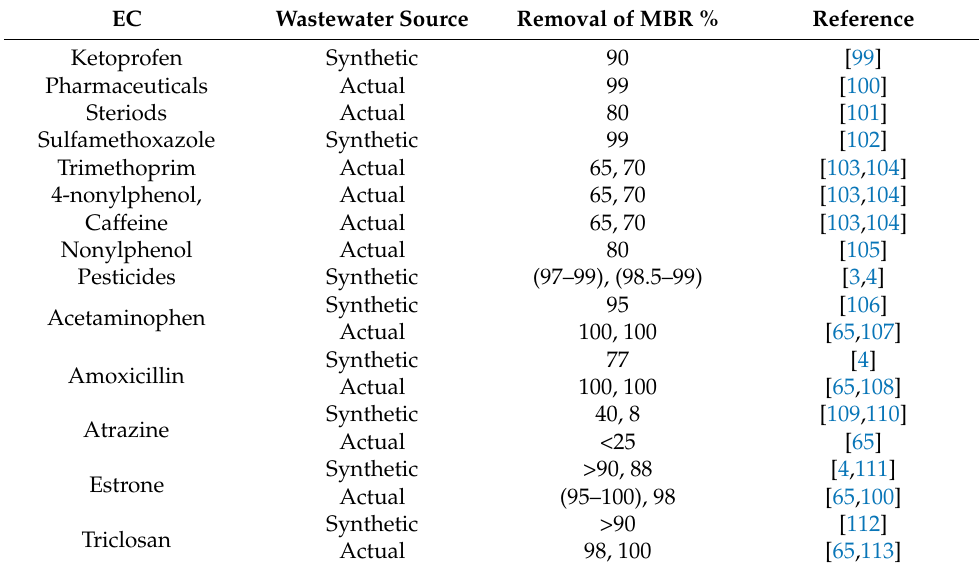
Table 2. Removal of ECs by MBR